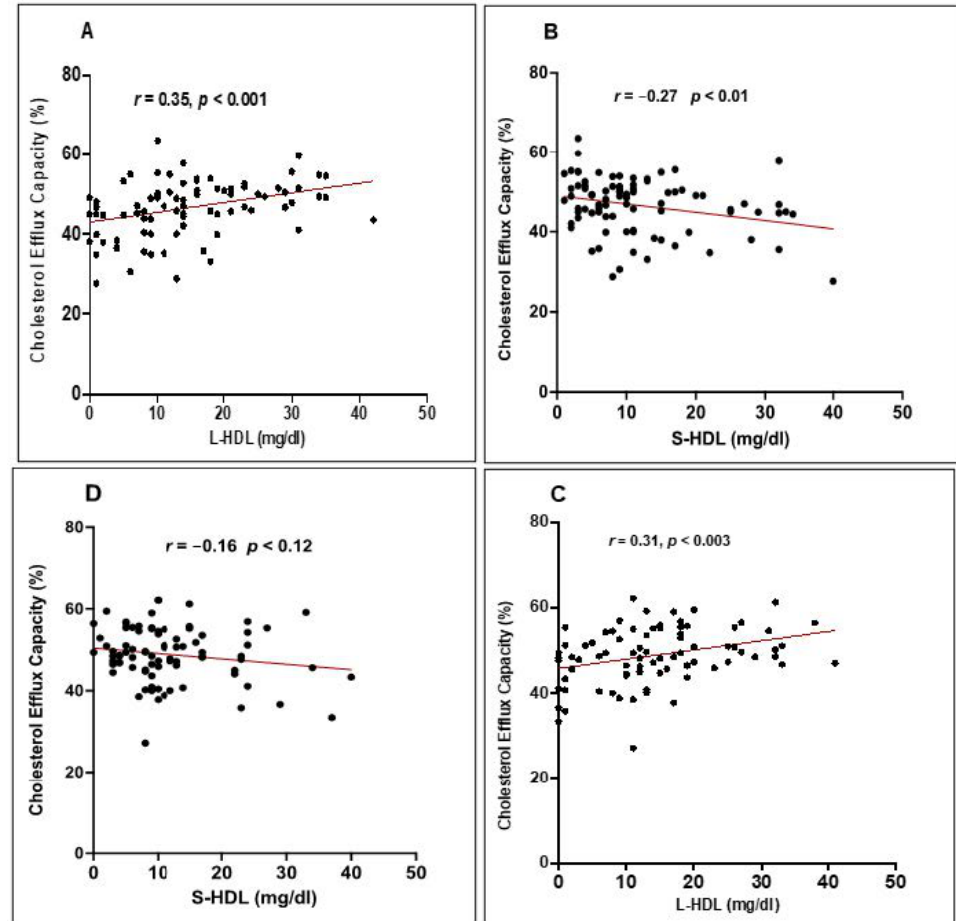
Figure 6. Correlation between HDL subclasses and CEC. Correlation between ( A ) L-HDL and ( B ) S-HDL and the CEC of HDL at baseline, and between ( C ) L-HDL and ( D ) S-HDL and the CEC of HDL after EVOO intake. The HDL subclass distribution was determined using Quantimetrix Lipoprint®HDL test kits. The CEC of HDL was expressed as the percentage of radiolabeled choles- terol transferred from ( 3 H) cholesterol-loaded J774 macrophages to HDL calculated as (cpm in medium/(cpm in medium + cpm in cellular lysates)) × 100.